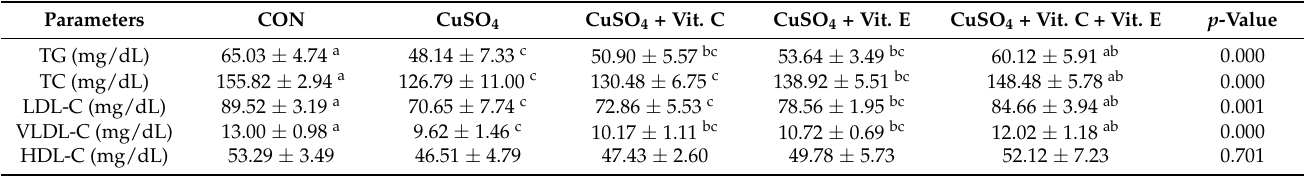
Table 5. Effect of single or combined supplementation of vitamin C and E on the lipid profile of broiler chickens at the end of the 3rd week (Mean ± SD, n = 5).